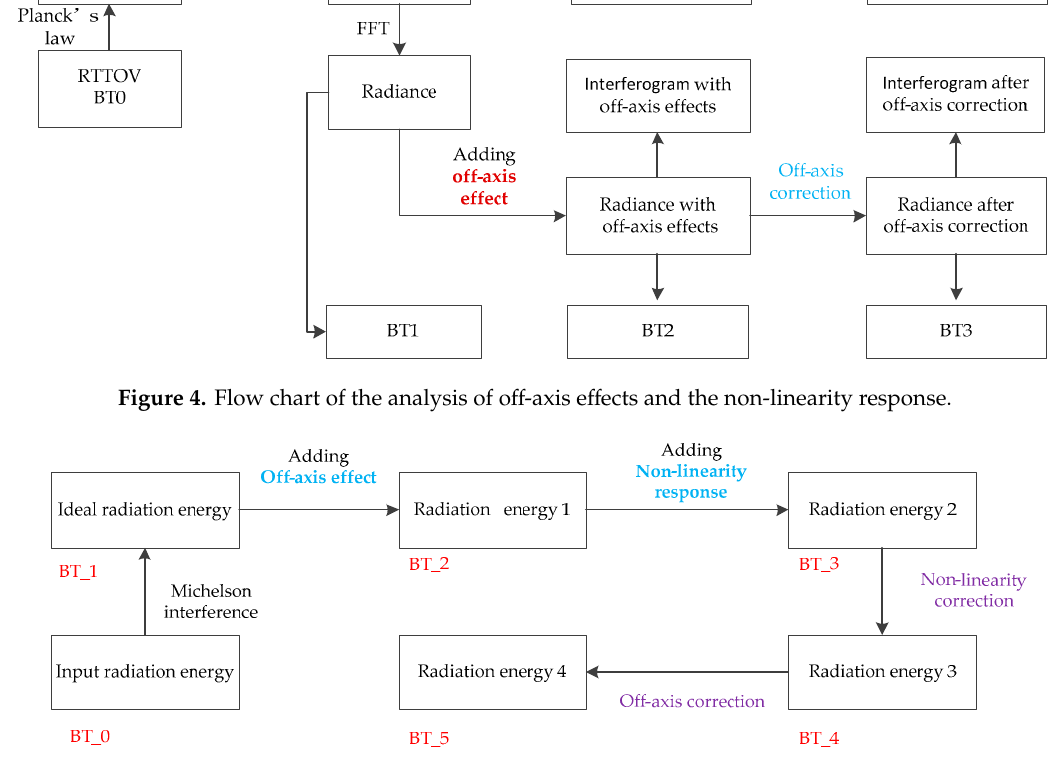
Figure 5. Flow chart of simulation process.